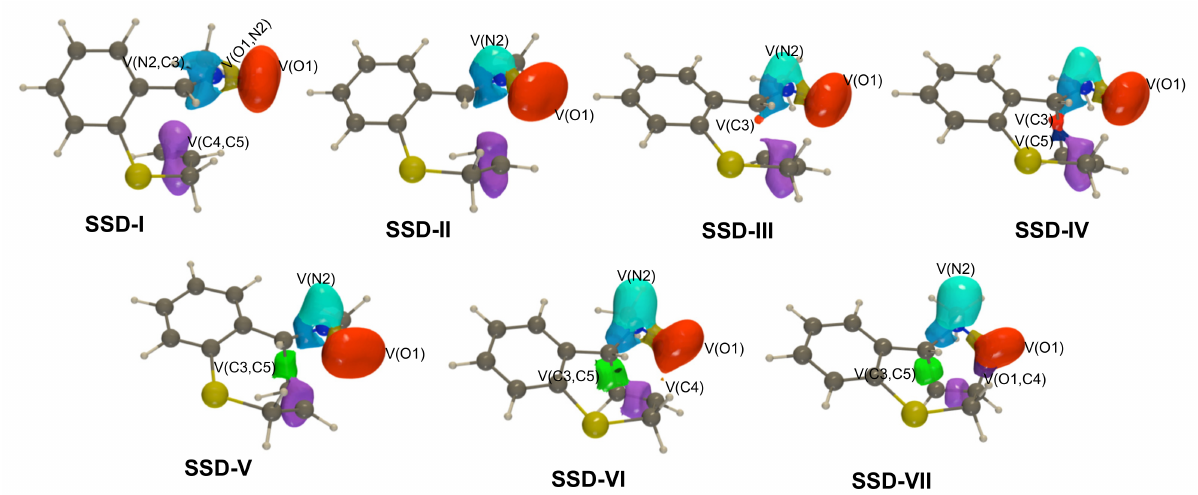
Figure 8. ELF basin isosurfaces ( η = 0.7) of each of the SSDs found along the IRC associated with TS3-b . Color labeling of the basins is adopted according to Figure S2.